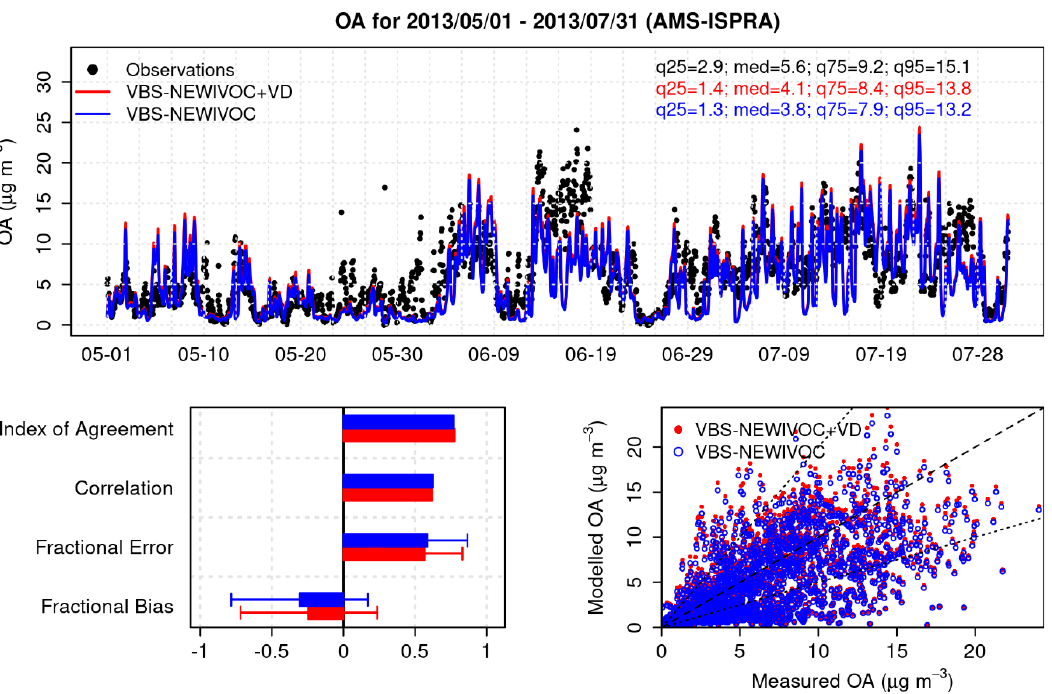
Figure 4. Comparison among modeled and observed (black) OA concentrations during May – July 2013 at the Ispra site: VBS scheme with new parameterizations for IVOC emissions (VBS-NEWIVOC, blue) and VBS scheme with new parameterizations for IVOC emissions and revised volatility distribution (VBS-NEWIVOC+VD, red).